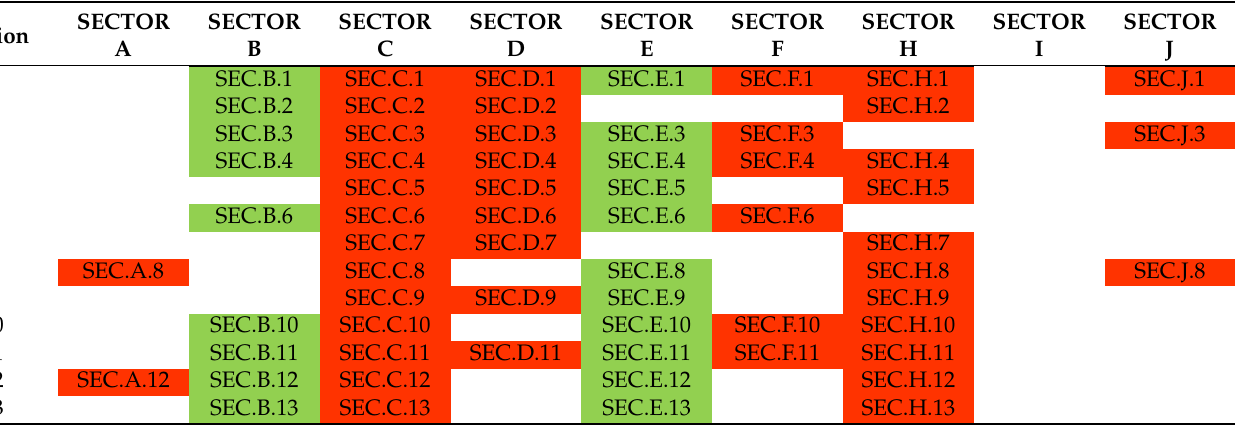
Table 2. Significant variables 1,2 of the Independent Samples t -test applied for the mean GVA